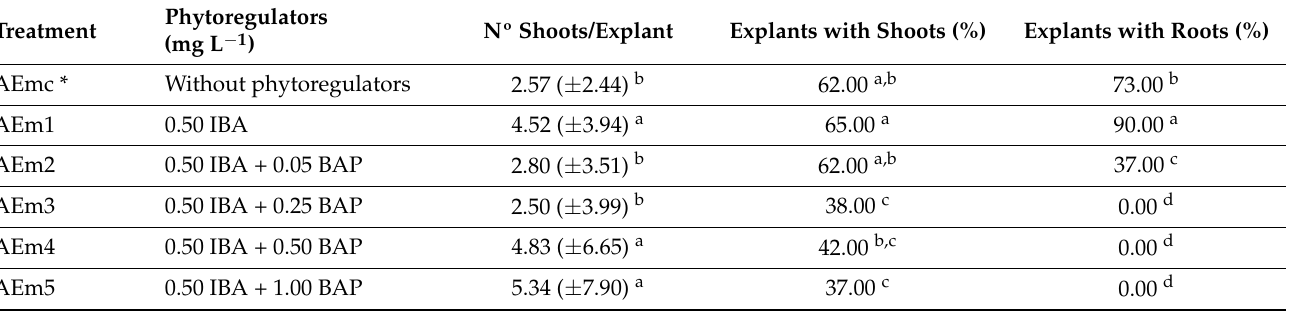
Table 3. Effects of the different multiplication treatments on the growth parameters measured in the initial explants of A. taltalensis